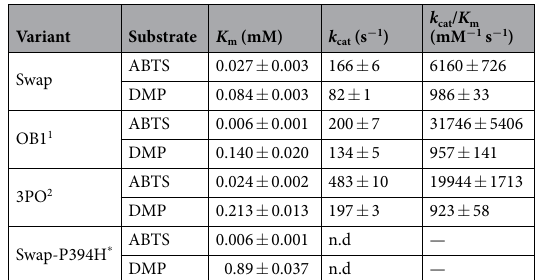
— Table 2. Kinetic constants for purified domain-swap laccase and parent-types OB1 and 3PO. 1 From Maté et al ., 2010 24 . 2 From Camarero et al . 2012 23 . * Crude